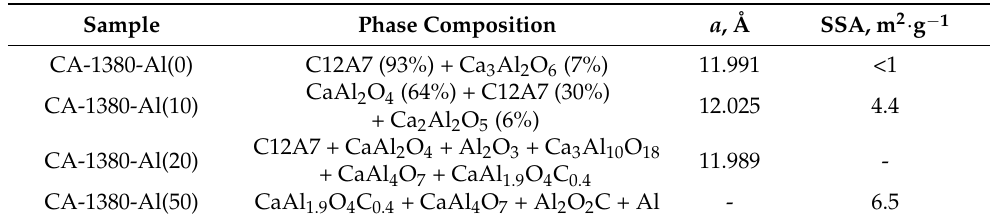
Figure 5. XRD patterns for the mayenite samples with varied content of aluminum additive after calcination in an Ar atmosphere at 1380 °C.